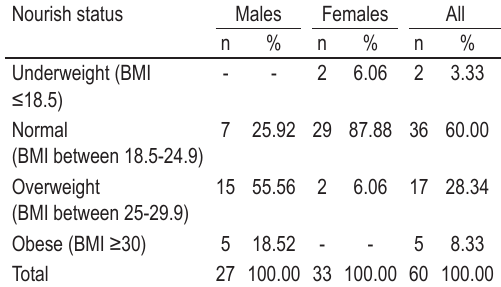
TABLE 2. Prevalence of obesity among students based